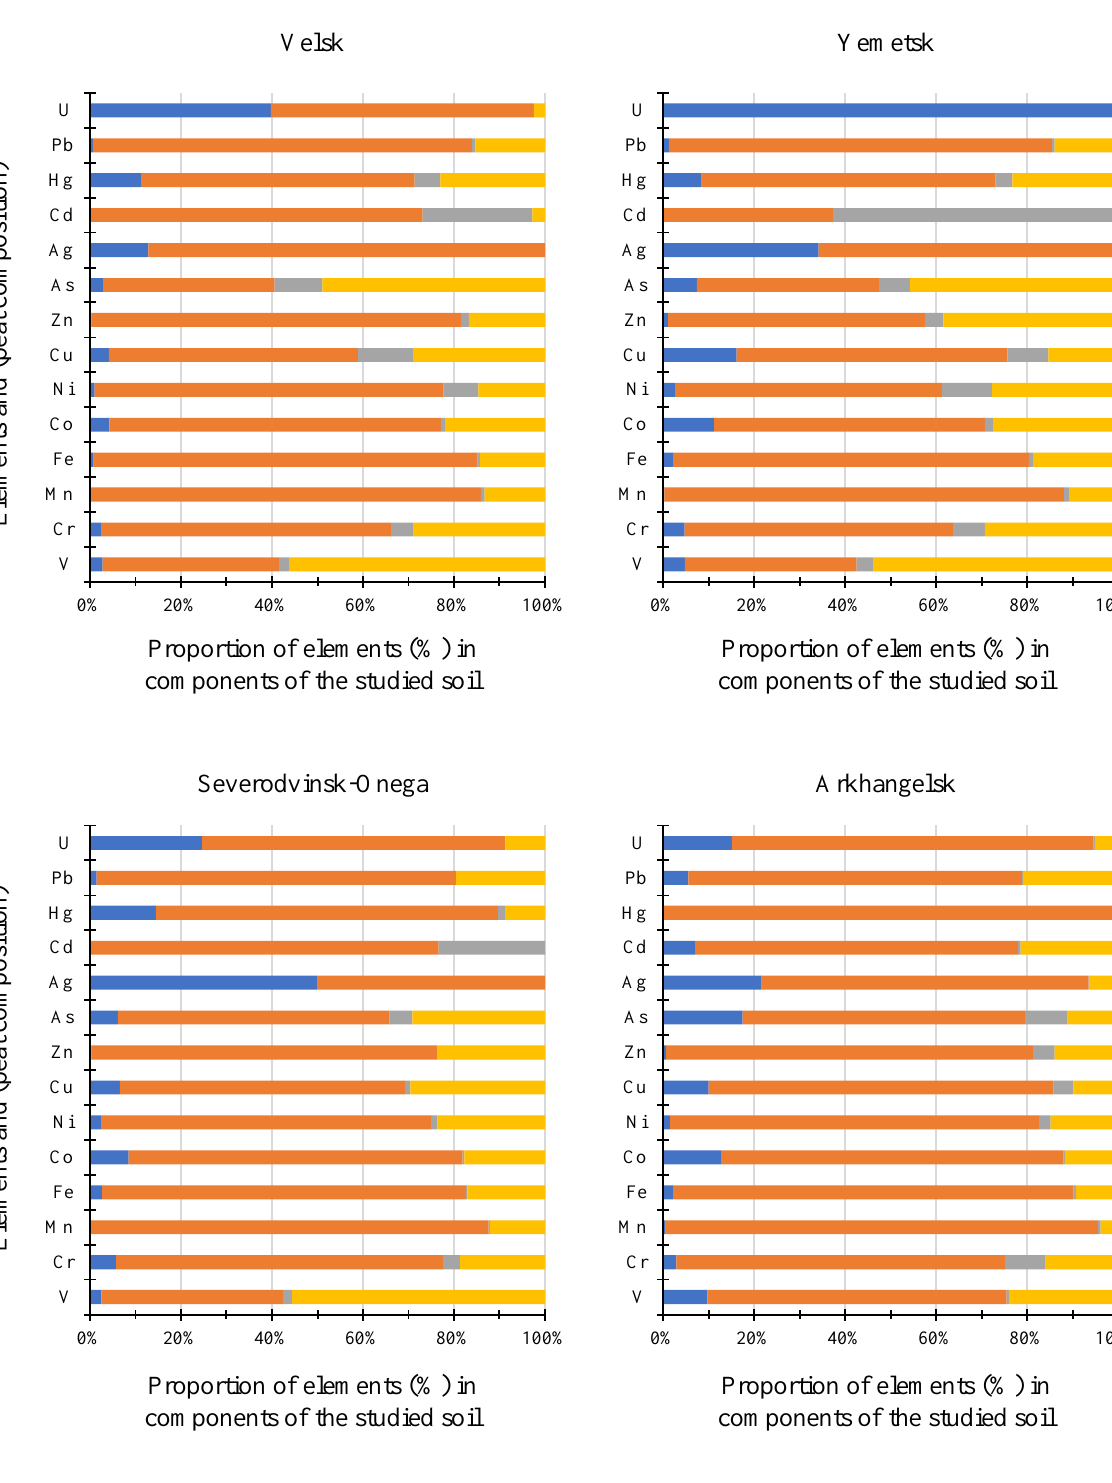
Figure A4. Distribution of elements between the components of peat at the four sampling locations: Velsk (top left), Yemetsk (top right), Severodvinsk-Onega (bottom left) and Arkhanelsk (bottom right). The components are, from left to right: humic acids (HA; blue), humin (orange), bitumen (grey) and fulvic acids (FA;